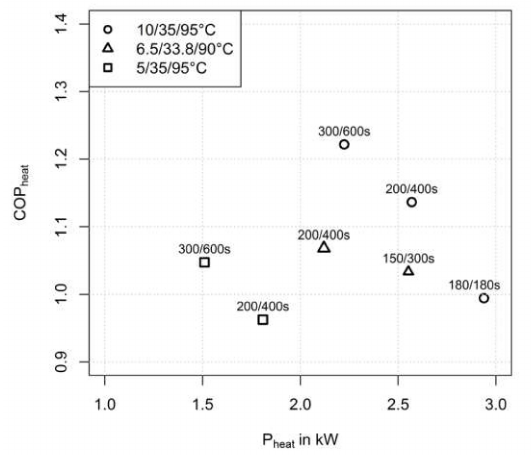
Figure 10. Efficiency and power for three different temperature conditions and different half cycle times. The half cycle times are given as desorption half cycle time followed by the adsorption half cycle time in the plot. The longer the half cycle time, the higher the efficiency due to the higher loading difference. Consequently, longer half cycle time corresponds with lower